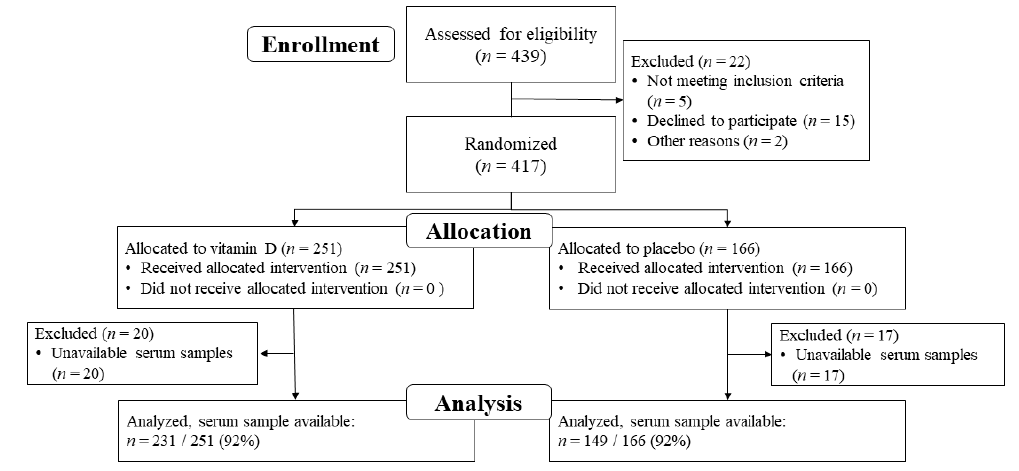
Figure 1. Flow chart of the research participants.